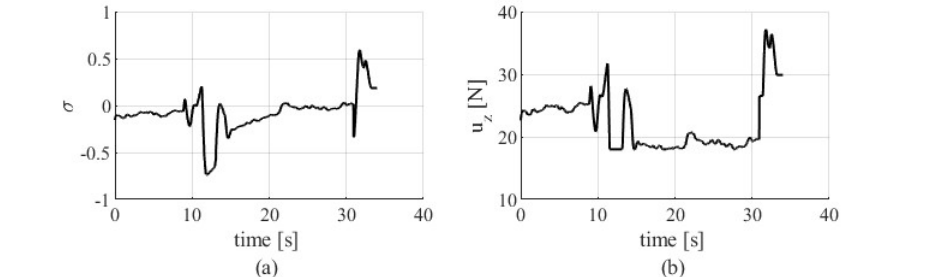
Figure 9. ( a ) The variable σ and ( b ) the control input ( u z ) performance of the proposed DOB altitude